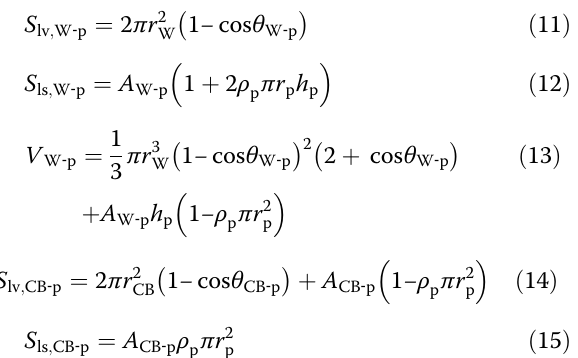
, S , S , and S lv,W-p lv,CB-p ls,W-p